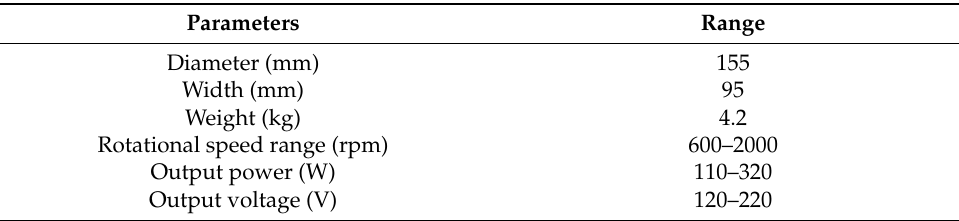
Table 1. The main parameters of the proposed AFPM